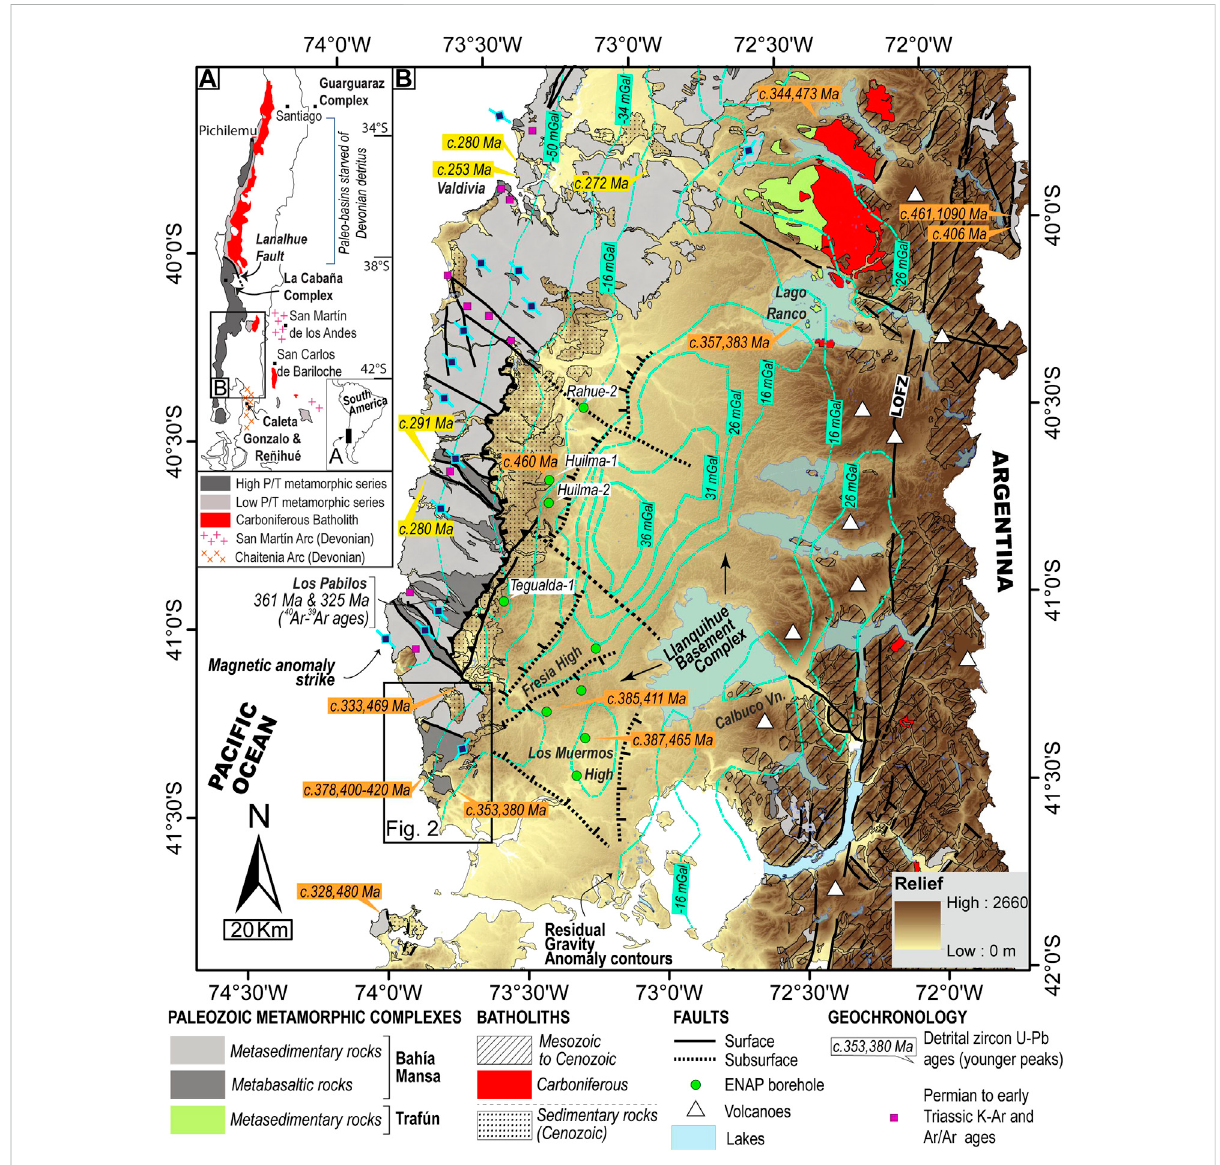
FIGURE 1 (A) Regional sketch map of south-central Chile showing the distribution of the Paleozoic igneous and metamorphic basement. The location of the Devonian arcs of San Martin and Chaitenia is highlighted. (B) Geological map of the Región de Los Lagos based on SERNAGEOMIN (2002). The subsurface fault traces and borehole locations are based on the work of Elgueta et al. (2000). LOFZ: Liquiñe-Ofqui Fault Zone. The residual gravity anomaly contours are based on the work of Yañez & Rivera (2019). The magnetic anomaly strike is based on the work of Godoy & Kato